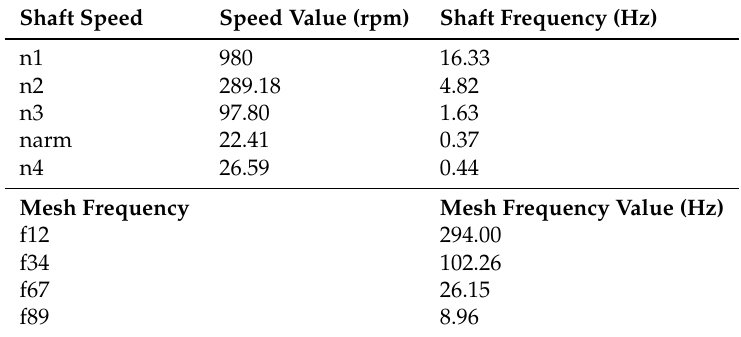
Table 1. Parameters of the system with gearbox: shaft speeds and mesh